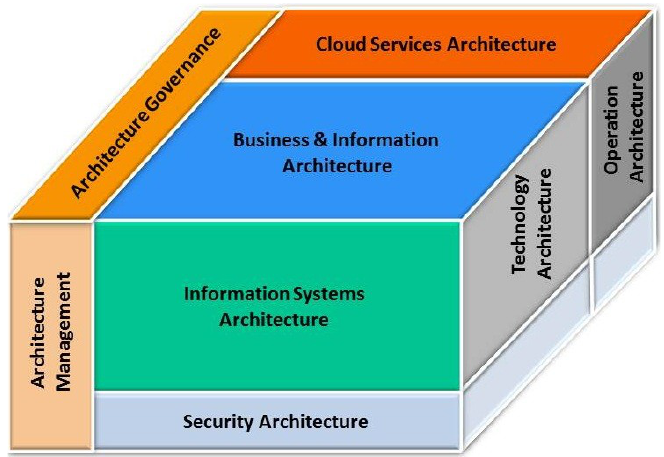
Figure 1. Enterprise Services Architecture Reference Cube [6], [41],